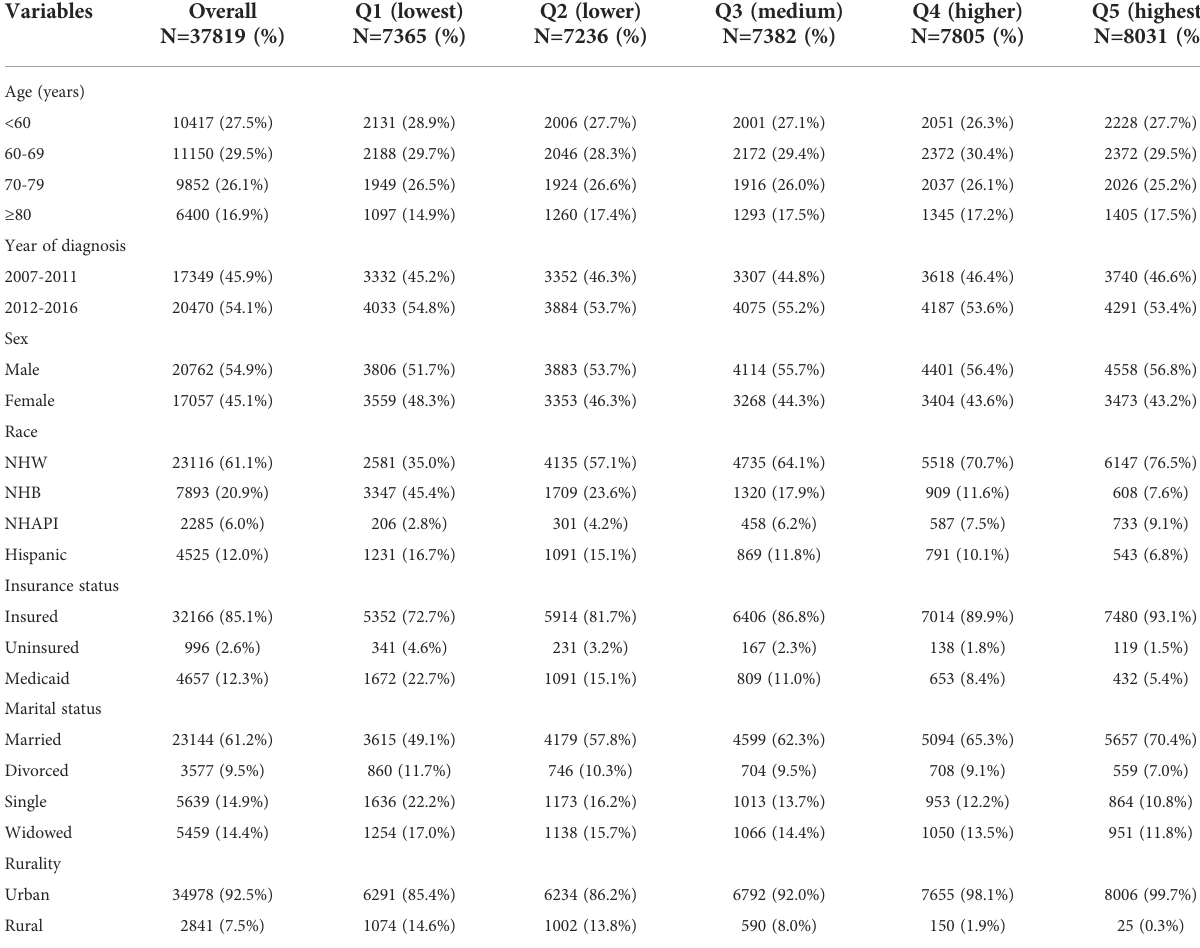
TABLE 1 Baseline sociodemographic characteristics of MM patients in the SEER cohort, grouped by SES index.